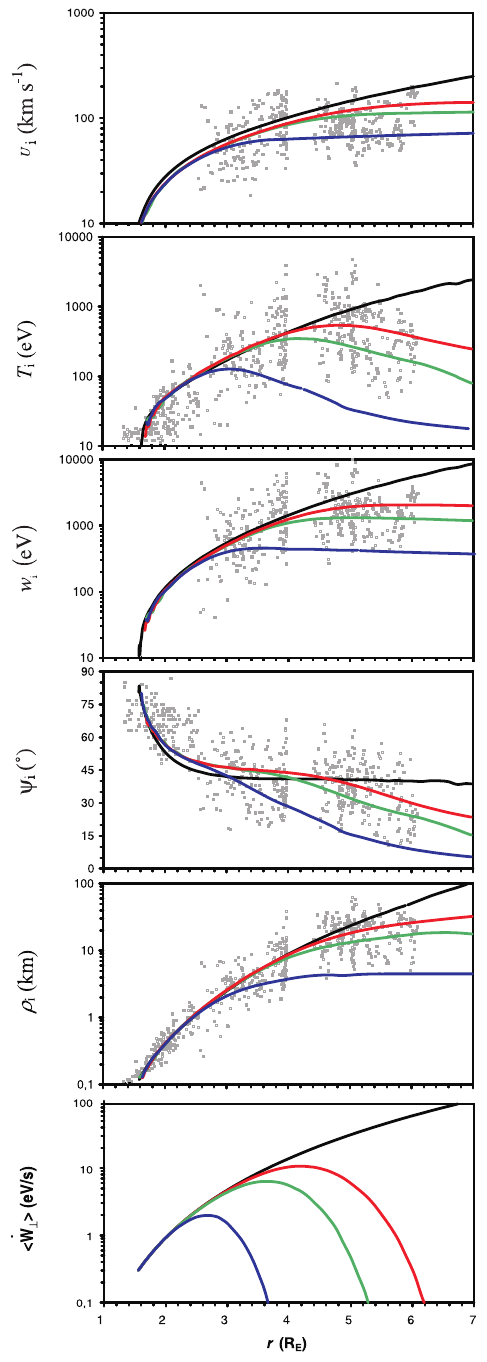
Fig. 6. Comparison along the poleward edge of the cusp/cleft be- tween scatterplots of O + quantities and those obtained from nu- merical simulations. From top to bottom, upward mean velocity in kms − 1 , temperature in eV, mean energy in eV, apex angle in ◦ , mean gyroradius in km, and velocity-averaged heating rate in eVs − 1 . Blue, green, red, and black curves correspond to different values of the perpendicular wavelength: 10km, 50km, 100km, and infinity, respectively. All other simulation parameters are summa- rized in Table 1 (i.e. run 1 to run